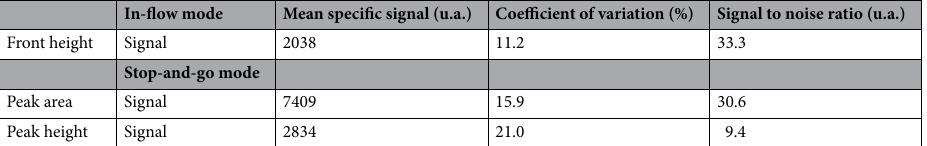
Table 3. Comparison between continuous and ‘stop-and-go’ methods for experiments performed with a sample of IL-6 at 10 ng/mL (for the specific signal) or a buffer solution mL (for the non-specific signal) as described in the Material and Methods.